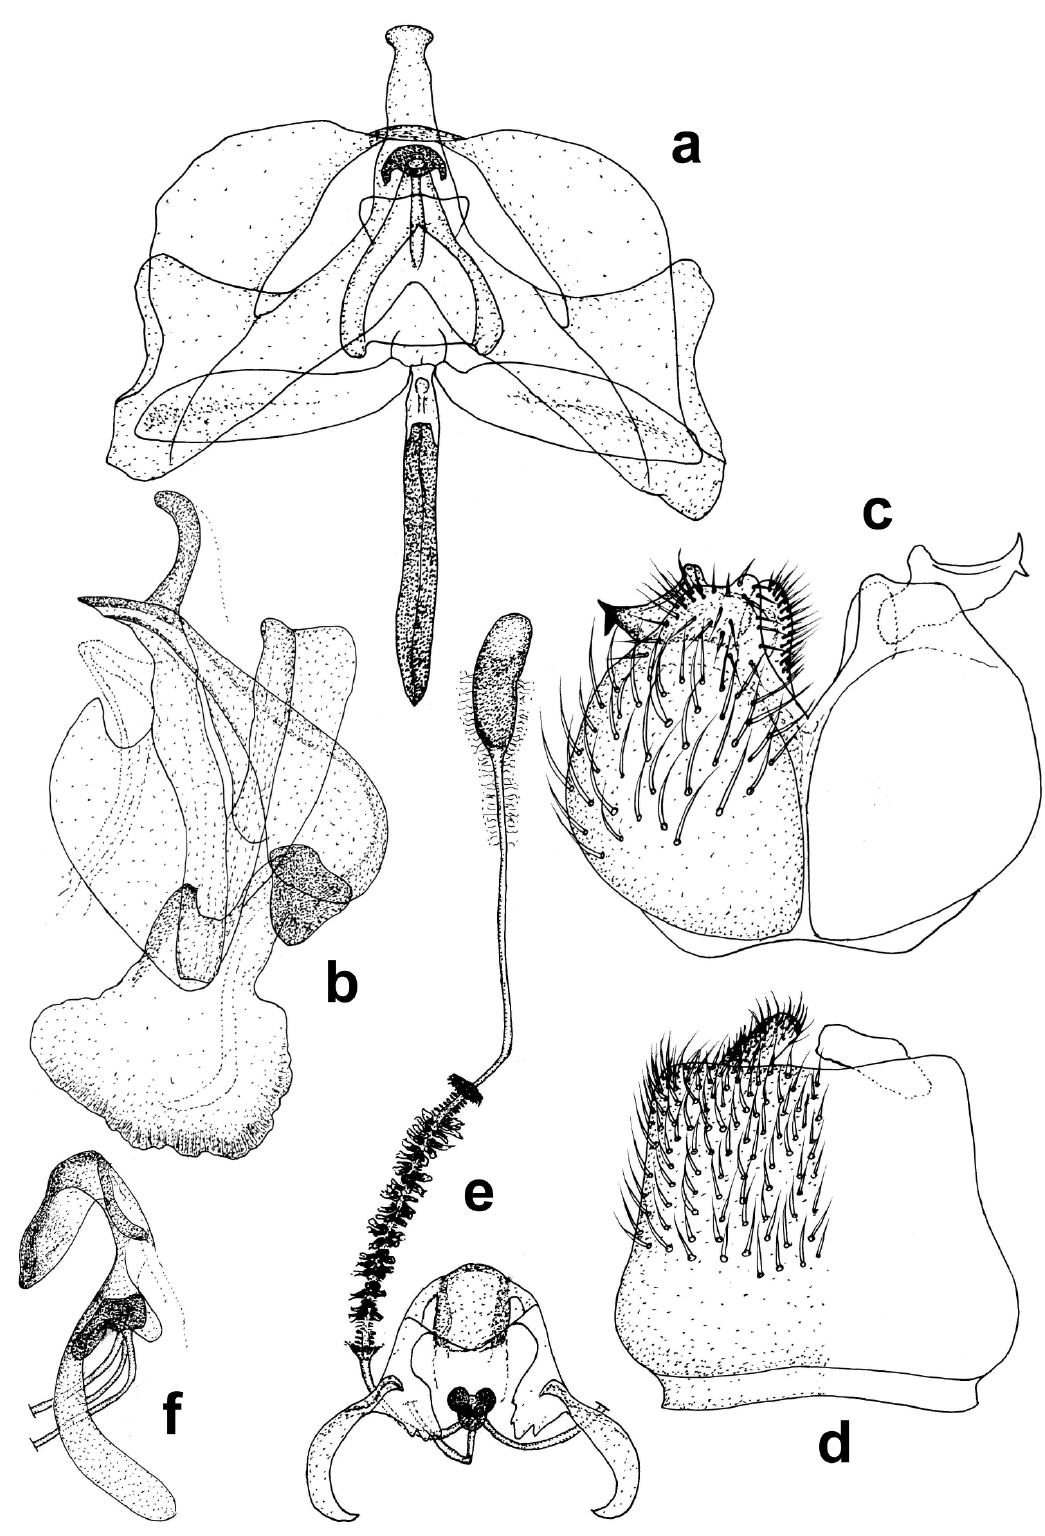
Fig. 47. Protypusia grisea (Paramonov, 1947) gen. et comb. nov. a . Epiphallic complex ventral. b . Epiphallic complex lateral. c . Gonocoxite ventral. d . Epandrium dorsal. e . Female genitalia ventral. f . Female genitalia